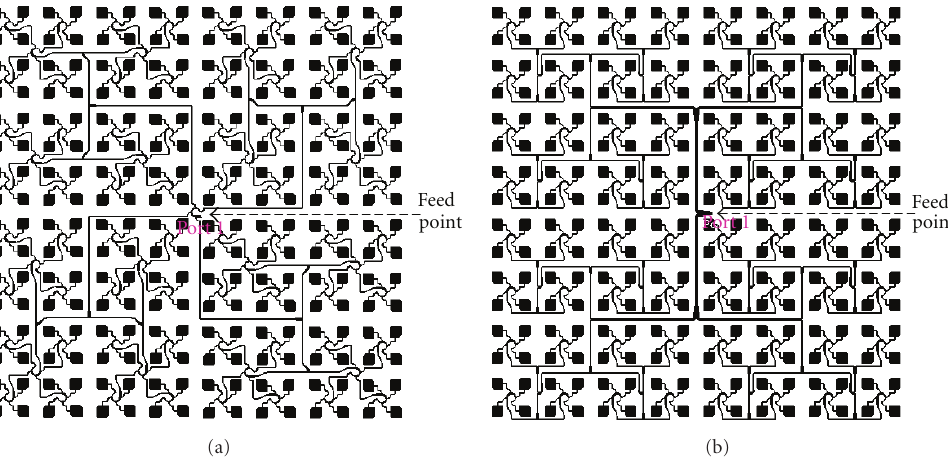
Figure 4: 256-element CP antenna arrays; (a) with the proposed multiple series-parallel sequential rotation feeding network; (b) with the conventional parallel feeding